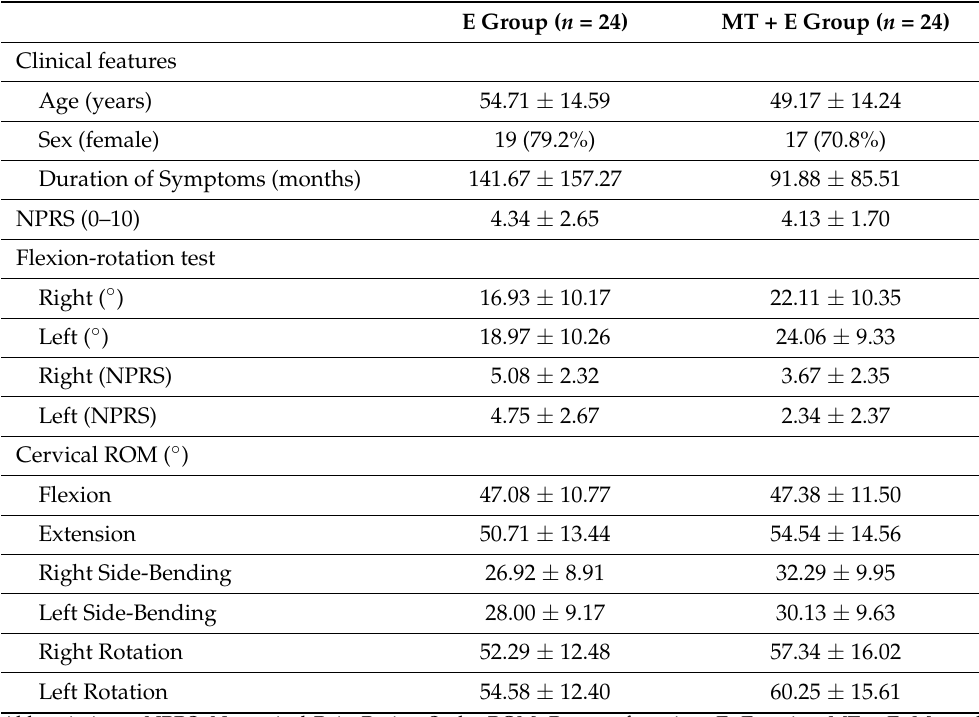
Table 1. Baseline Features for Both Groups.